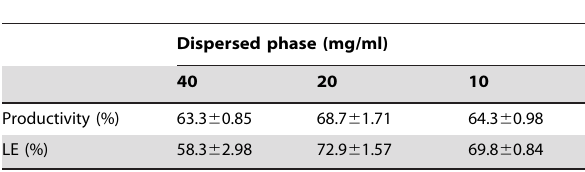
Table 1. Comparison of different dispersed phase a .